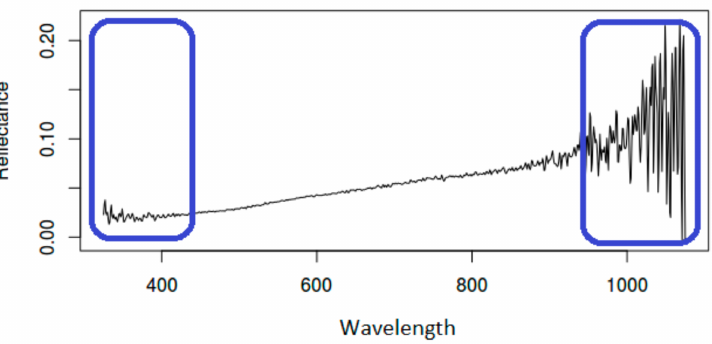
Figure 3. Sample reflectance of the soil sample measured with FieldSpec HandHeld2